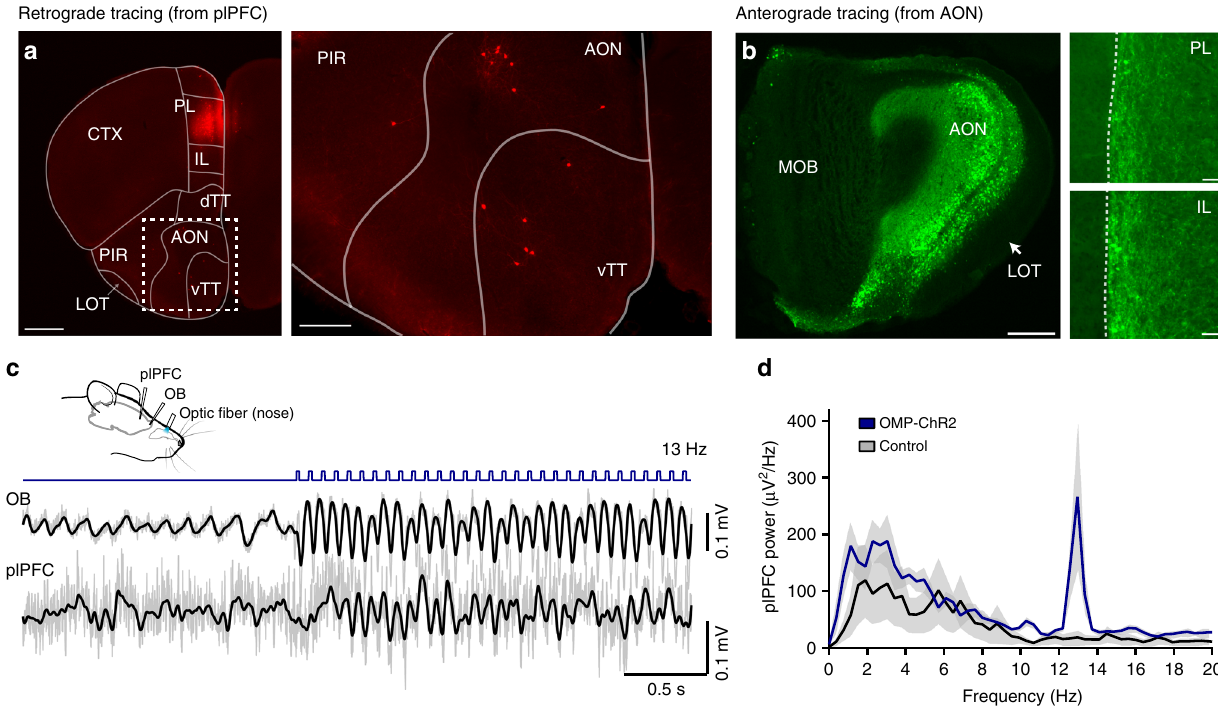
Fig. 4 Optogenetic stimulation of olfactory sensory neurons in the nose entrains rhythmic activity in the OB and plPFC. a The prelimbic PFC (PL) receives direct inputs from the ipsilateral anterior olfactory nucleus (AON) and ventral taenia tecta (vTT). Focal injection of 0.5 µ l CAV2-cre (13 × 10 12 GC/ml) into the PL in Rosa tdTomatof/f reporter mice leads to labeled cell bodies in the AON and vTT, two regions receiving direct inputs from the OB. CTX cortex, PIR piriform cortex, LOT lateral olfactory tract, dTT dorsal taenia tecta. Scale bar: 750 µ m, left panel and 250 µ m, right panel. b Focal injection of Cre-dependent ChR2-EYFP virus directed to the AON in Vglut1-Cre mice results in labeled fi bers in both the prelimbic (PL) and infralimbic (IL) PFC. Note that there is essentially no viral infection in the main olfactory bulb (MOB, left panel) and the projection from AON to the prefrontal cortex is only on the ipsilateral side (right panel). Scale bar: 200 µ m, left panel and 30 µ m, right panel. The dotted lines mark the midline separating the two hemispheres. c An optical fi ber was implanted in the nose of OMP-ChR2 mice to stimulate OSNs. The example shows stimulation at 13 Hz (15 mW, 20 ms), which is distinct from endogenous respiration rhythms. Simultaneous LFP recordings from the OB and plPFC show optical stimulation-entrained neural activity. Filtered signals (2 – 20 Hz) are overlaid on raw traces (gray). Blue bars mark the laser (473 nm) pulses. d The power spectral density (mean ± SEM, n = 3 mice) of plPFC LFPs shows increased power at 13 Hz, the optical stimulation frequency (blue). The black line shows data from control mice ( n = 3, OMP Cre/WT without ChR2)